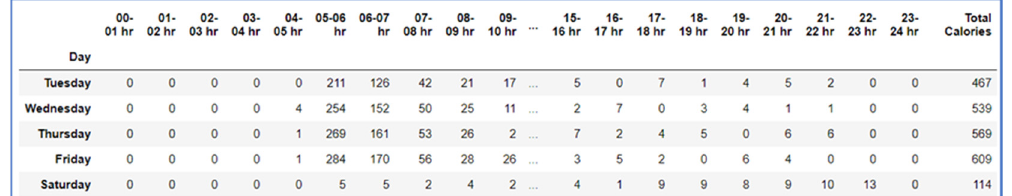
14 of 22 Figure 6. Sample of contextual features dataset (for Total Calories).